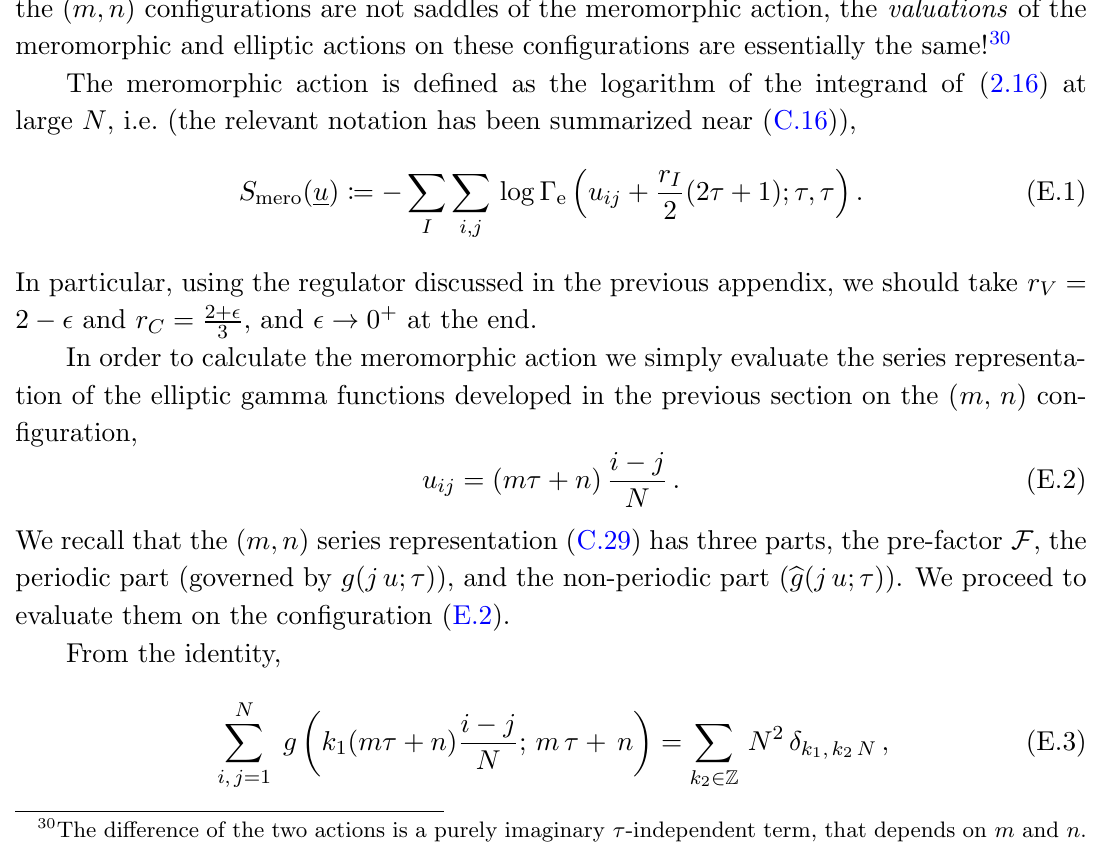
Figure 11 . (cid:0) Re S (0 ; 0) (Orange) vs (cid:0) Re S (0 ; 1) = 0 (Red). The unit of the vertical axis is N 2 We have used the representation (C.29) with m = 1 and n = 0, with a truncation at j = 2000. The plot on the left covers the domain (cid:28) 1 2 [ (cid:0) 2 ; 1] and (cid:28) 2 2 [0 : 2 ; 1 : 5], and the plot on the right